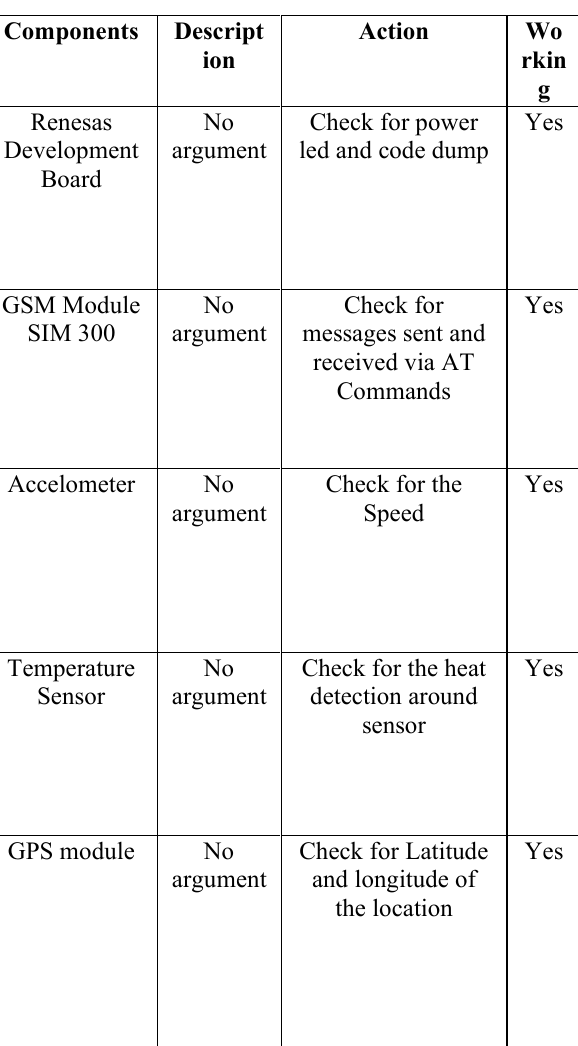
Figure 11. Flow Chart of L23D Motor Driver IC and DC Motor